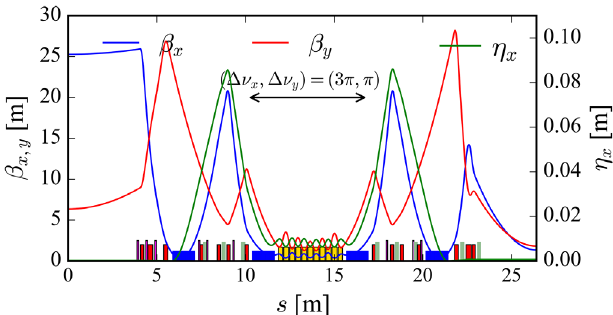
FIG. 3. Twiss functions along one cell of a lattice option for the upgrade of NSLS-II, based on Complex Bend technology. The CB magnet is colored in yellow, the sextupoles in green, and the octupoles in pink.